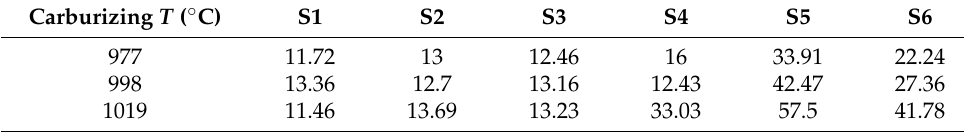
Table 3. The average grain size of each case after pseudocarburization ( μ m).